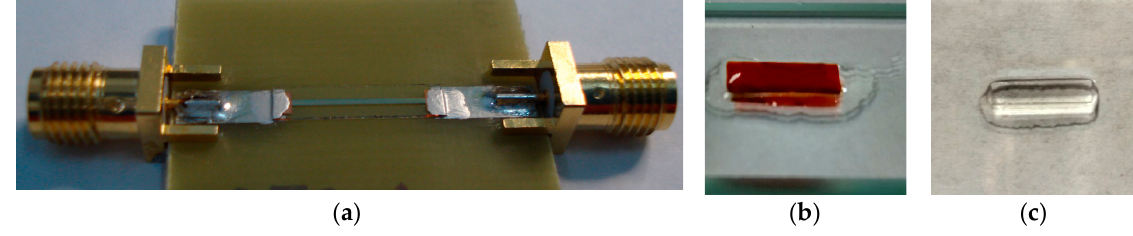
Figure 2. General view of the ribbon-based MI sensitive element installed into the “microstripe” line ( a ); general view of ferrogel ( b ) and gel; ( c ) pieces cut for MI measurements.